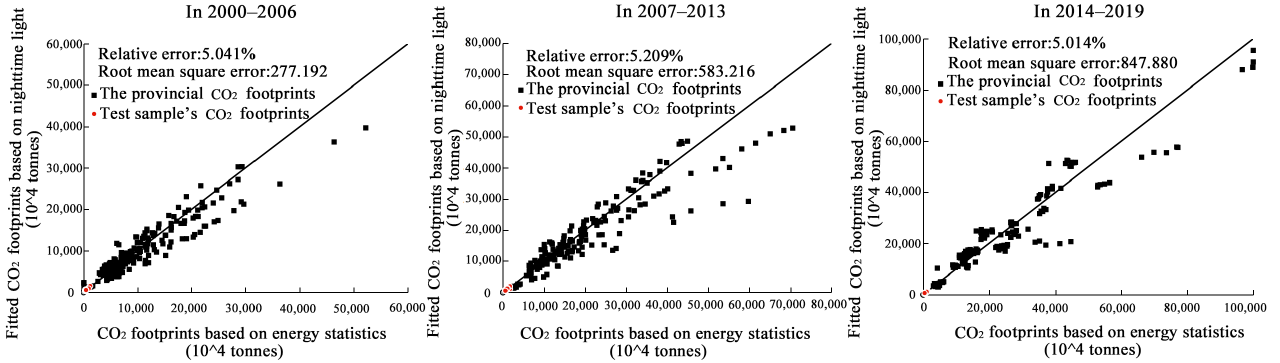
Figure 3. Deviation of the fitted CO 2 footprints based on night-time light from the CO 2 footprints based on energy